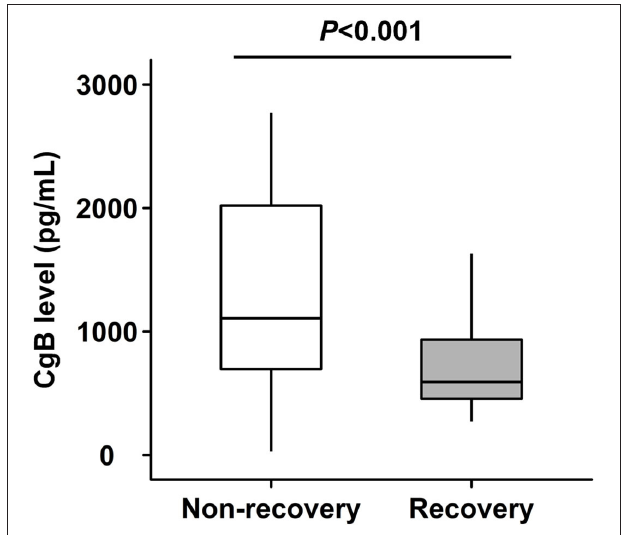
FIGURE 2 | Levels of chromogranin B (CgB) in patients with or without left ventricular (LV) functional recovery after recanalization of chronic total occlusion (CTO) lesions.